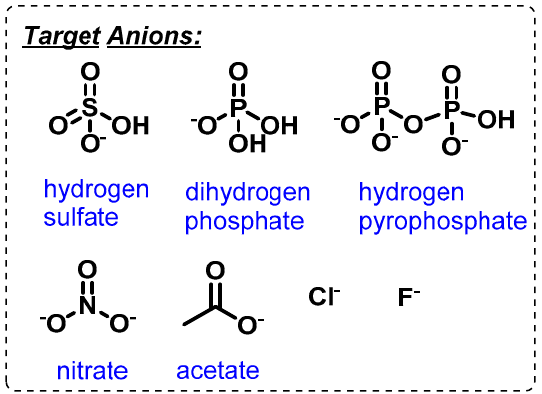
Figure 5. Anions targeted in this study.